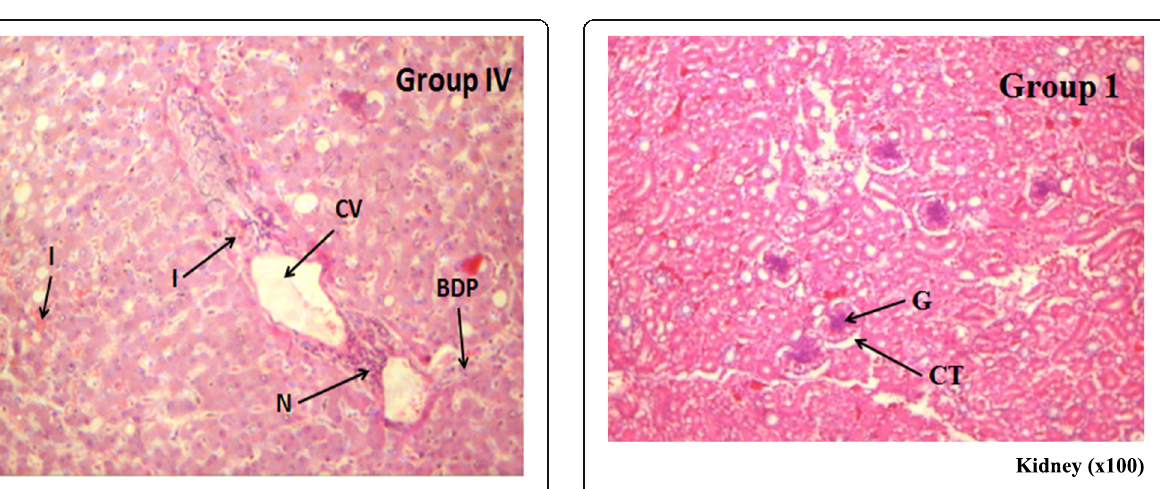
Fig. 4 Photomicrographs of the kidney obtained from a bird in the